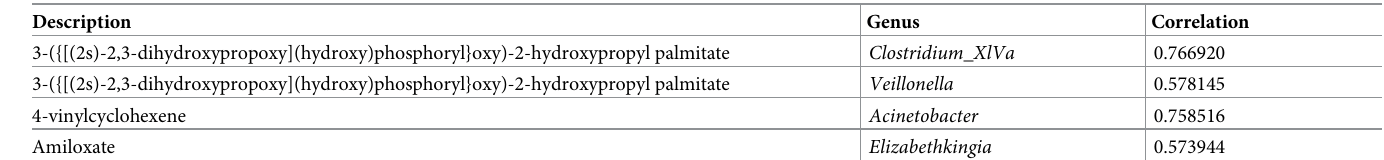
Table 2. Correlation of the metabolite levels with the abundance of gut microbiota in the model and treatment groups.